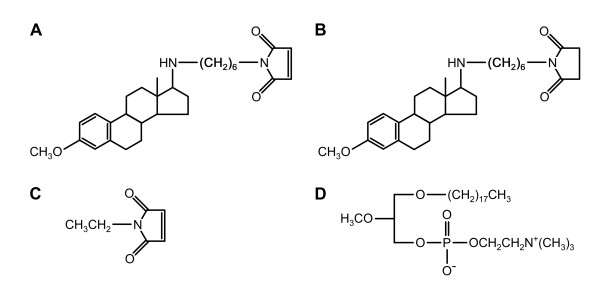
Chemical structures of PLC inhibitors and controls. Chemical structures of (A) U73122, (B) U73343, (C) NEM and (D) ET-18-OCH3.